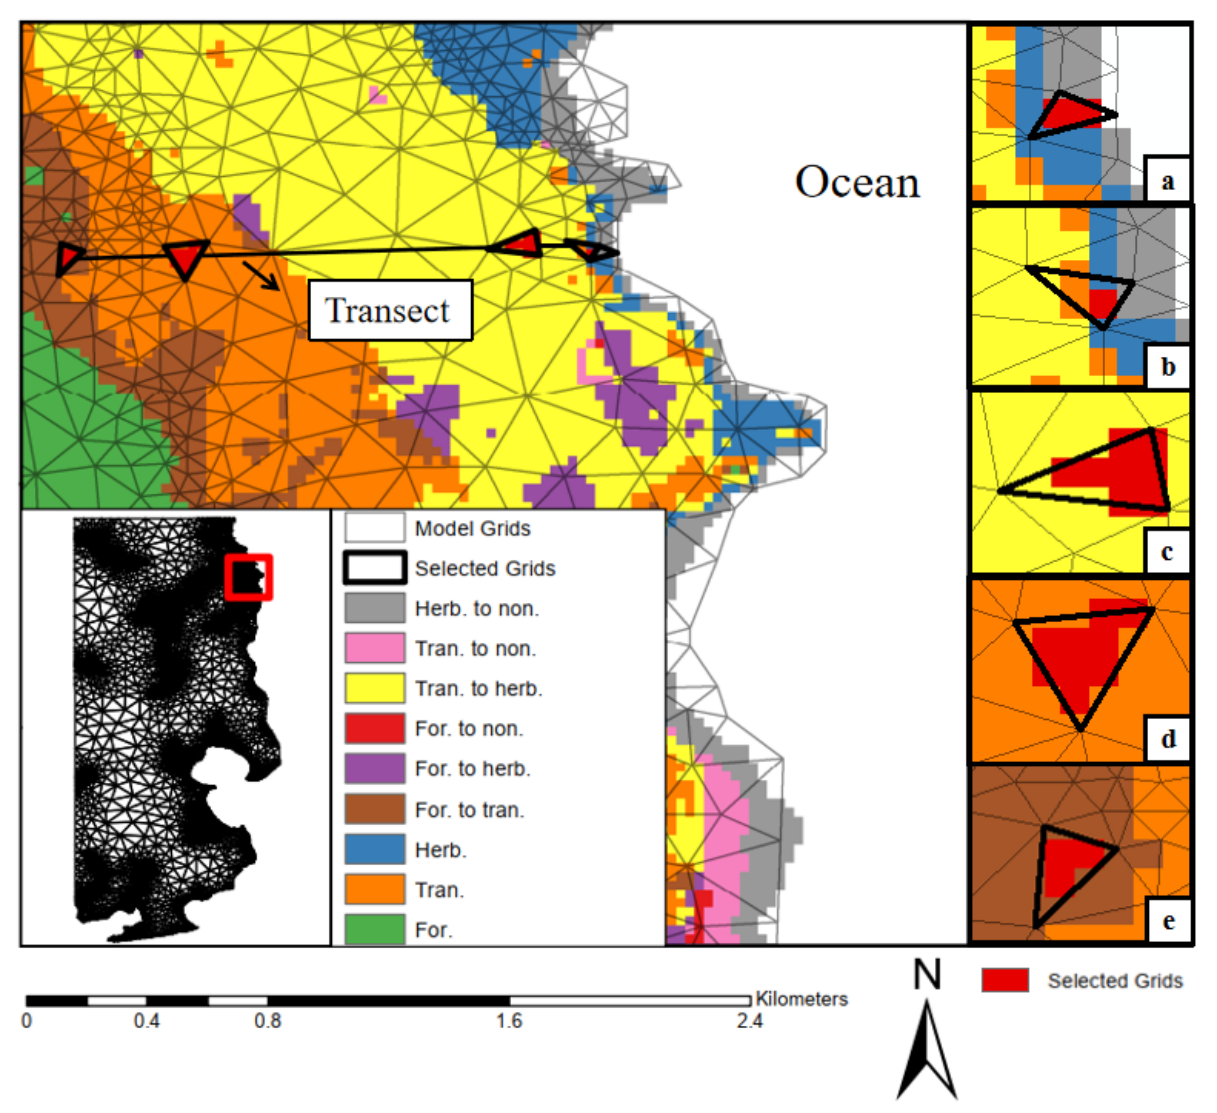
Figure 8. The selected transect and representative model triangular grids. ( a ) Emergent herbaceous wetlands degrading to non-vegetated areas (Type 6 degradation); ( b ) Emergent herbaceous wetlands without degradation; ( c ) Transitional forested wetlands degrading to emergent herbaceous wetlands (Type 5 degradation); ( d ) Transitional forested wetlands without degradation; ( e ) Forested wetlands degrading to transitional forested wetlands (Type 3 degradation). (For.: Forested wetlands; Tran.: Transitional forested wetlands; Herb.: Emergent herbaceous wetlands; Non.: Non-vegetated